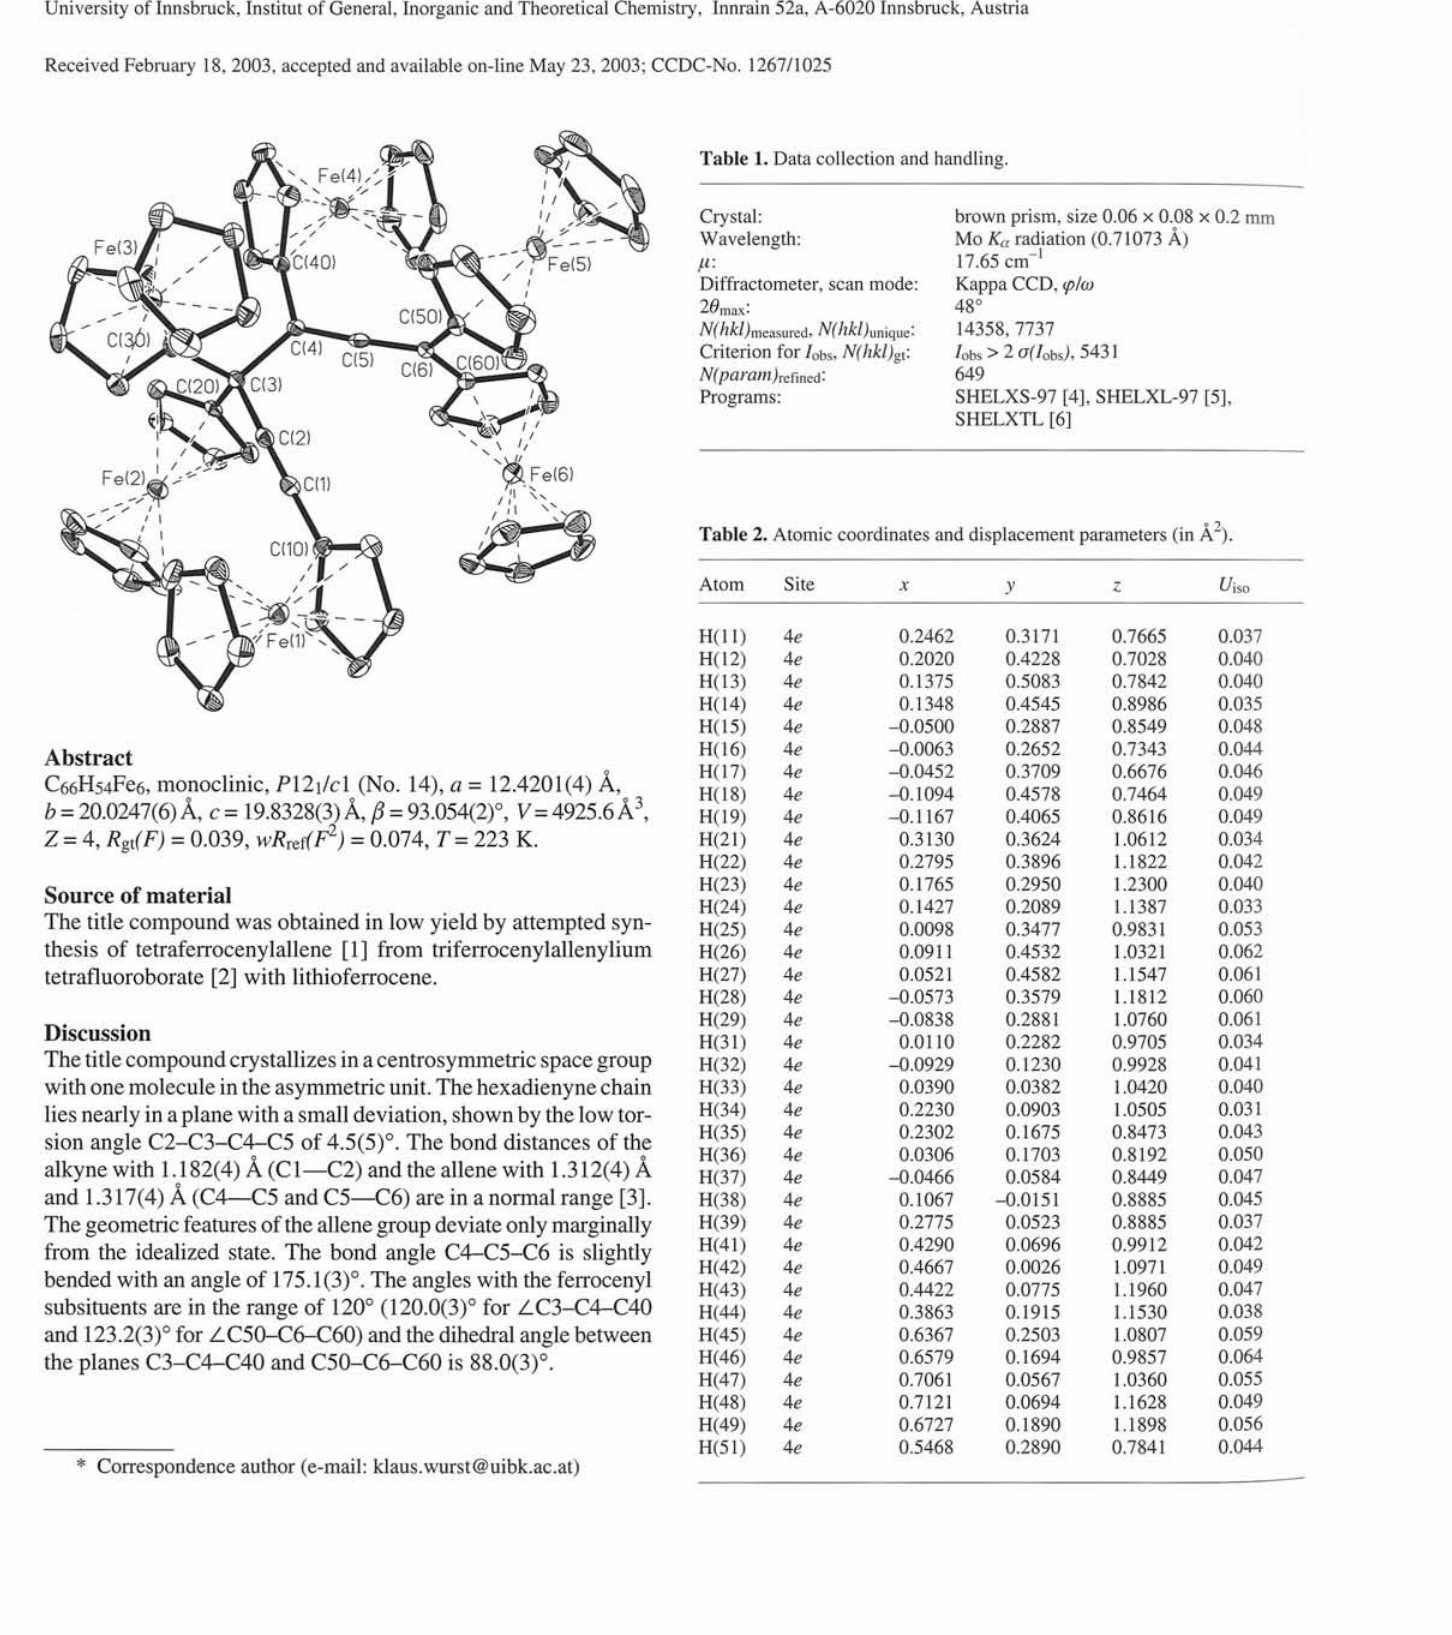
Table 2. Atomic coordinates and displacement parameters (in